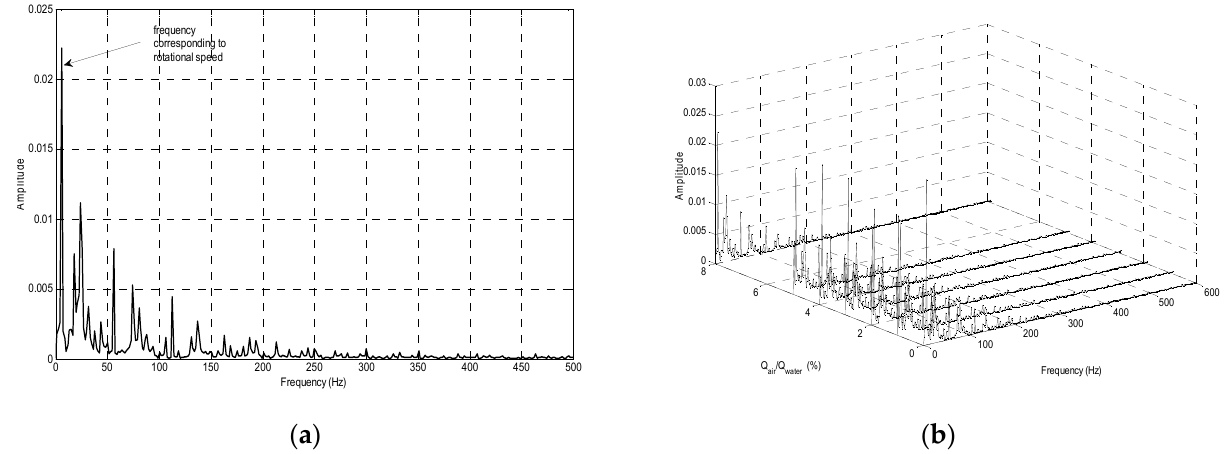
Figure 10. Amplitude spectrum of the vibrations obtained from displacement sensors on radial and axial direction, located on the radial–axial bearing, ( a ) for no air injection case and ( b ) for all operation regimes with different air flow rate injections [38].